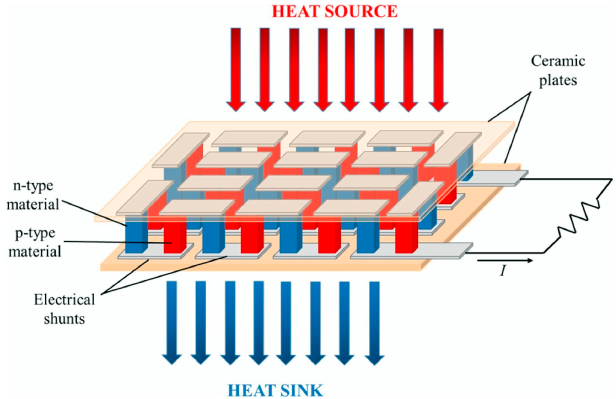
Figure 18. Scheme of thermoelectric power generation [146]-reprinted by permission from Elsevier.